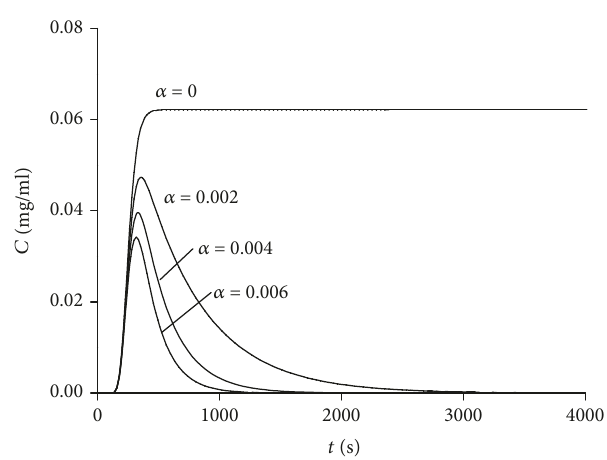
Figure 7: Relationship between particle concentration and time for four decay factors, using parameters given in Table 6.